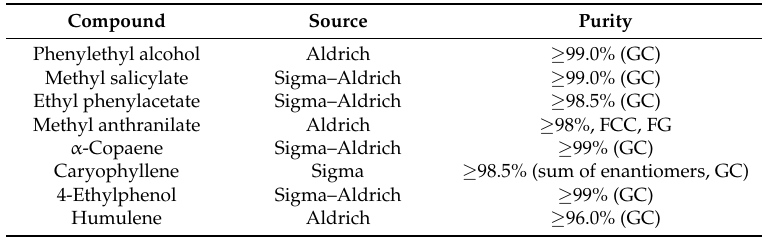
Table 4. Volatile compounds used for individual test against P. litchii in vitro.